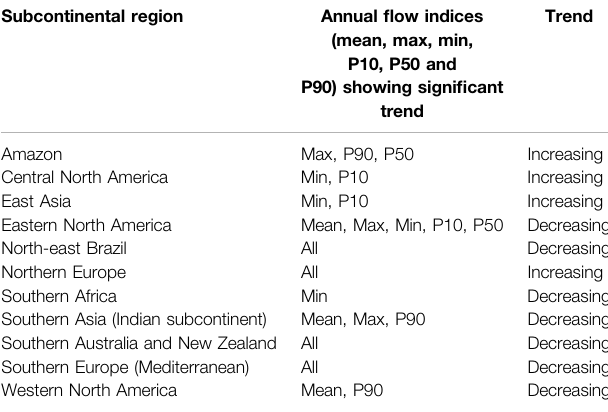
TABLE 2 | Signi fi cant trends in regional stream fl ow from around the world, between 1971 and 2010. Annual fl ow indices are: mean (mean fl ow),